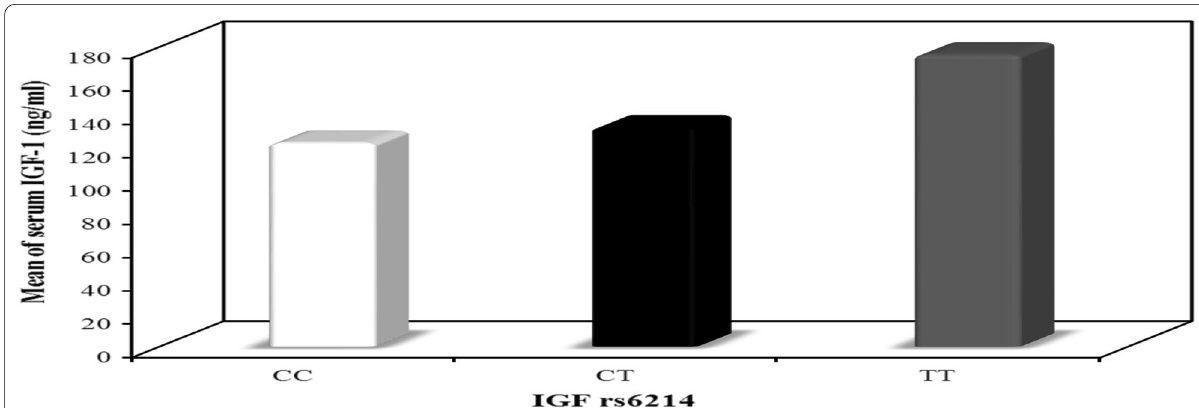
Fig. 4 The levels of Serum IGF-1 in different genotypes of IGF-1 rs6214 in colorectal Cancer group ( n